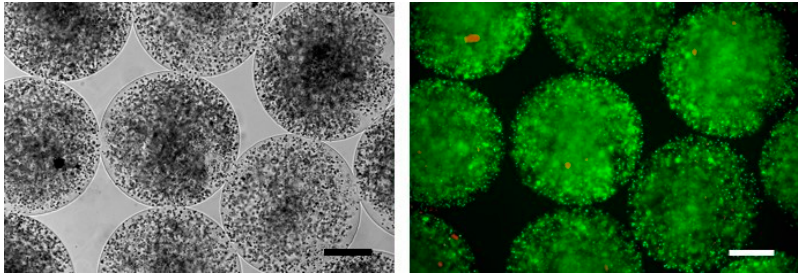
Figure 2. MC-SeC as viewed by phase contrast microscopy ( Left ) or by epi-fluorescence after staining with ethidium bromide (orange) and fluorescein diacetate (green) to analyze cell viability ( Right ). Bars, 200